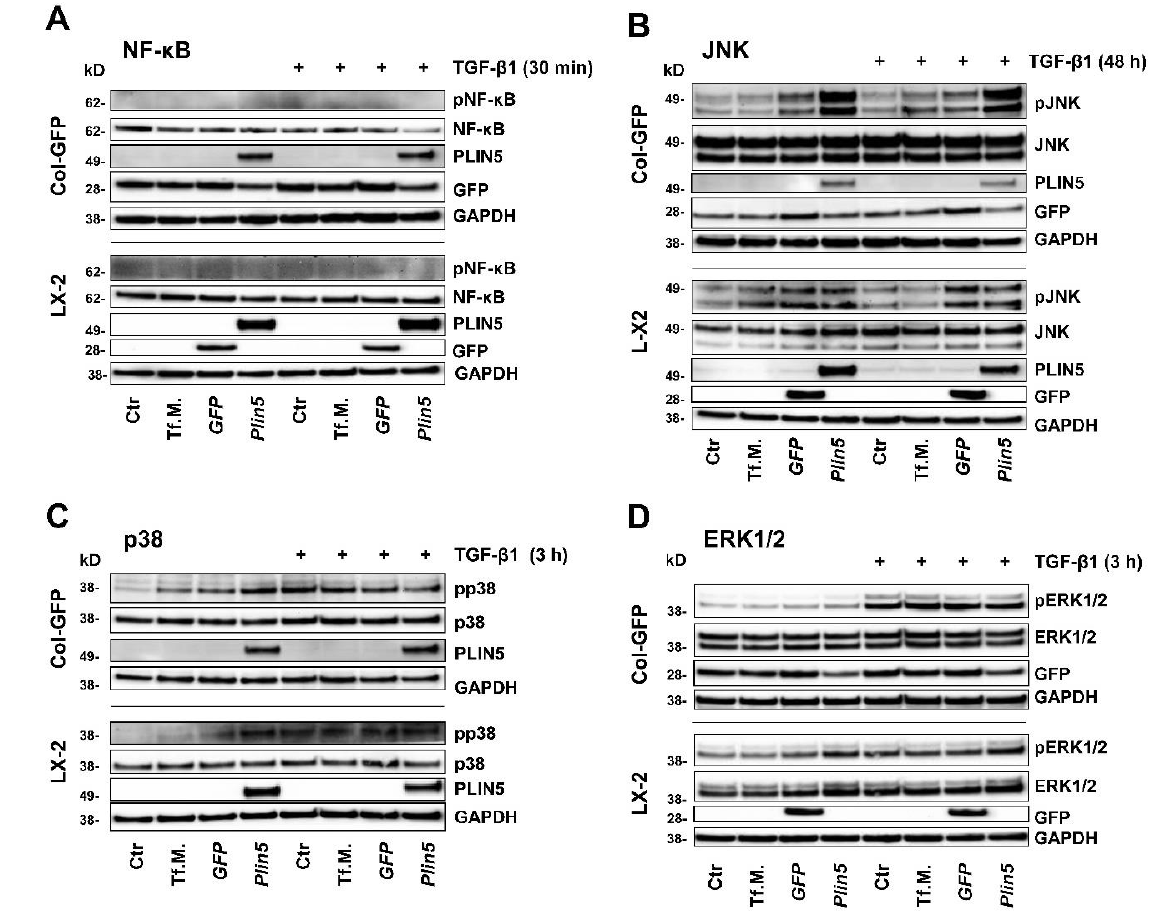
Figure 3. Unclear involvement of MAPKs and NF- κ B in TGF- β 1-mediated activation of HSC-cell lines and no or indistinct effect of Plin5 -transfection. Western blot analysis of protein extracts isolated from Plin5 transfected Col-GFP and LX-2 cells stimulated with TGF- β 1 for indicated time intervals (Col-GFP, 1 ng/mL; LX-2, 2.5 ng/mL). ( A ) Phosphorylated and total NF- κ B quantities 30 min after TGF- β 1 stimulation were determined. ( B ) Phosphorylated and total JNK after stimulation with TGF- β 1 for 48 h. ( C ) Phosphorylated and total p38 after 3 h stimulation. ( D ) Phosphorylated and total ERK1/2 after 3 h stimulation. All experiments were performed in triplicate. Tf.M., transfection medium; Ctr, control.